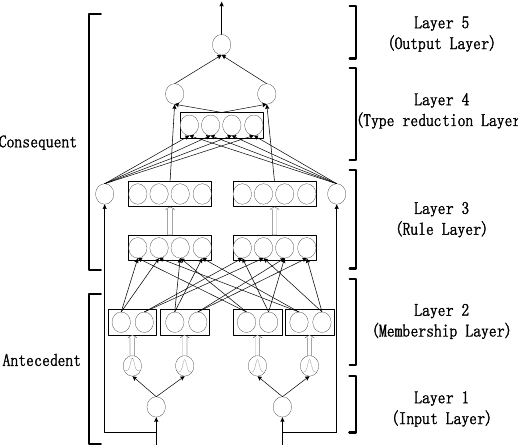
Figure 2. Network structure diagram of IT2FNN.